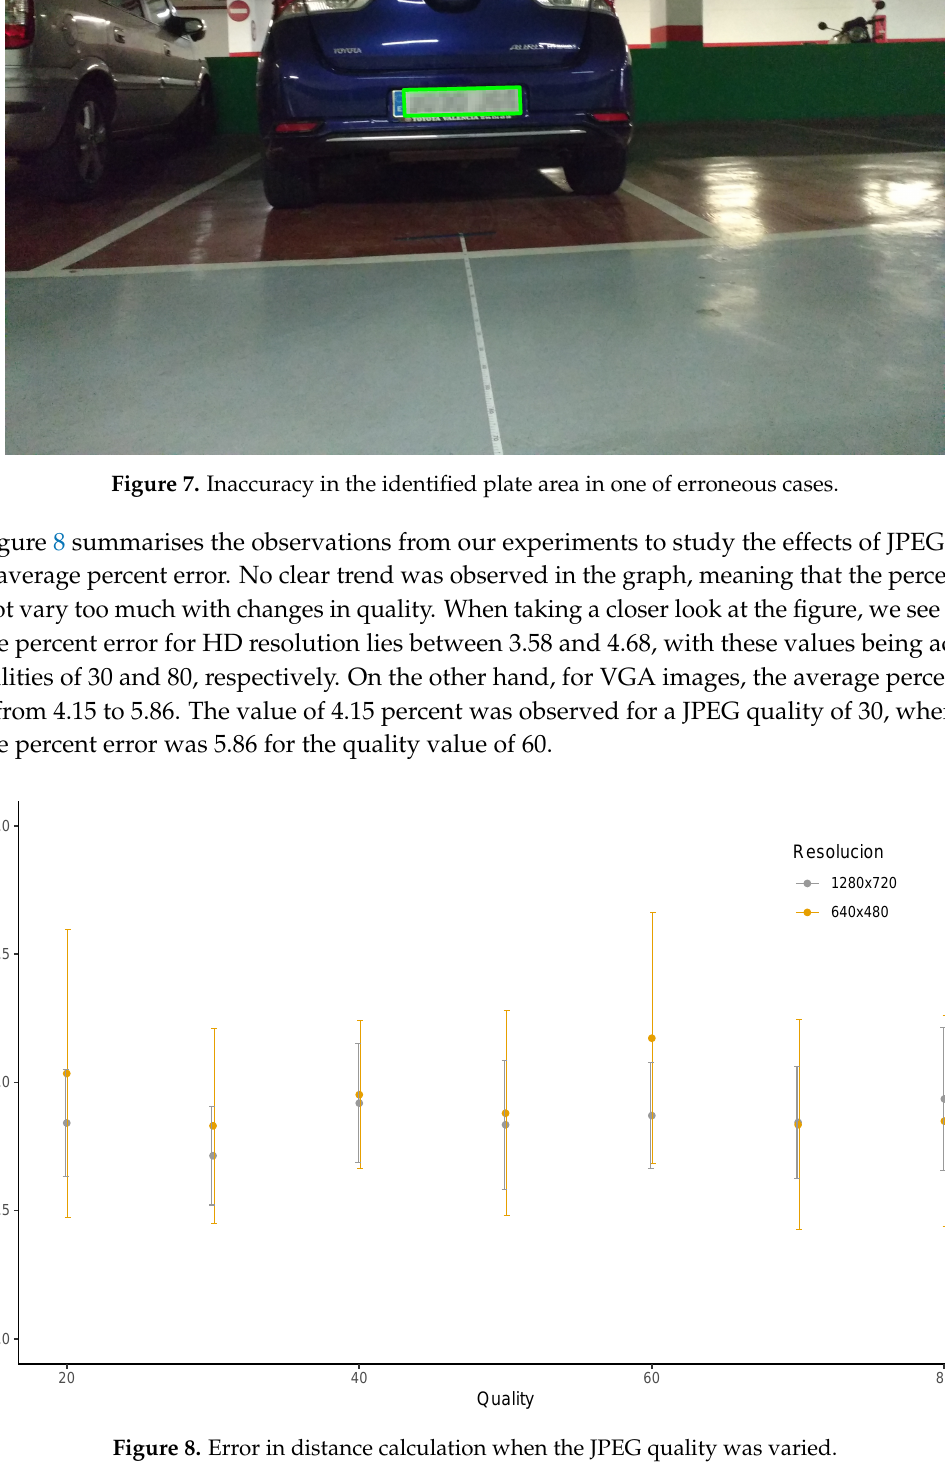
Figure 8. Error in distance calculation when the JPEG quality was